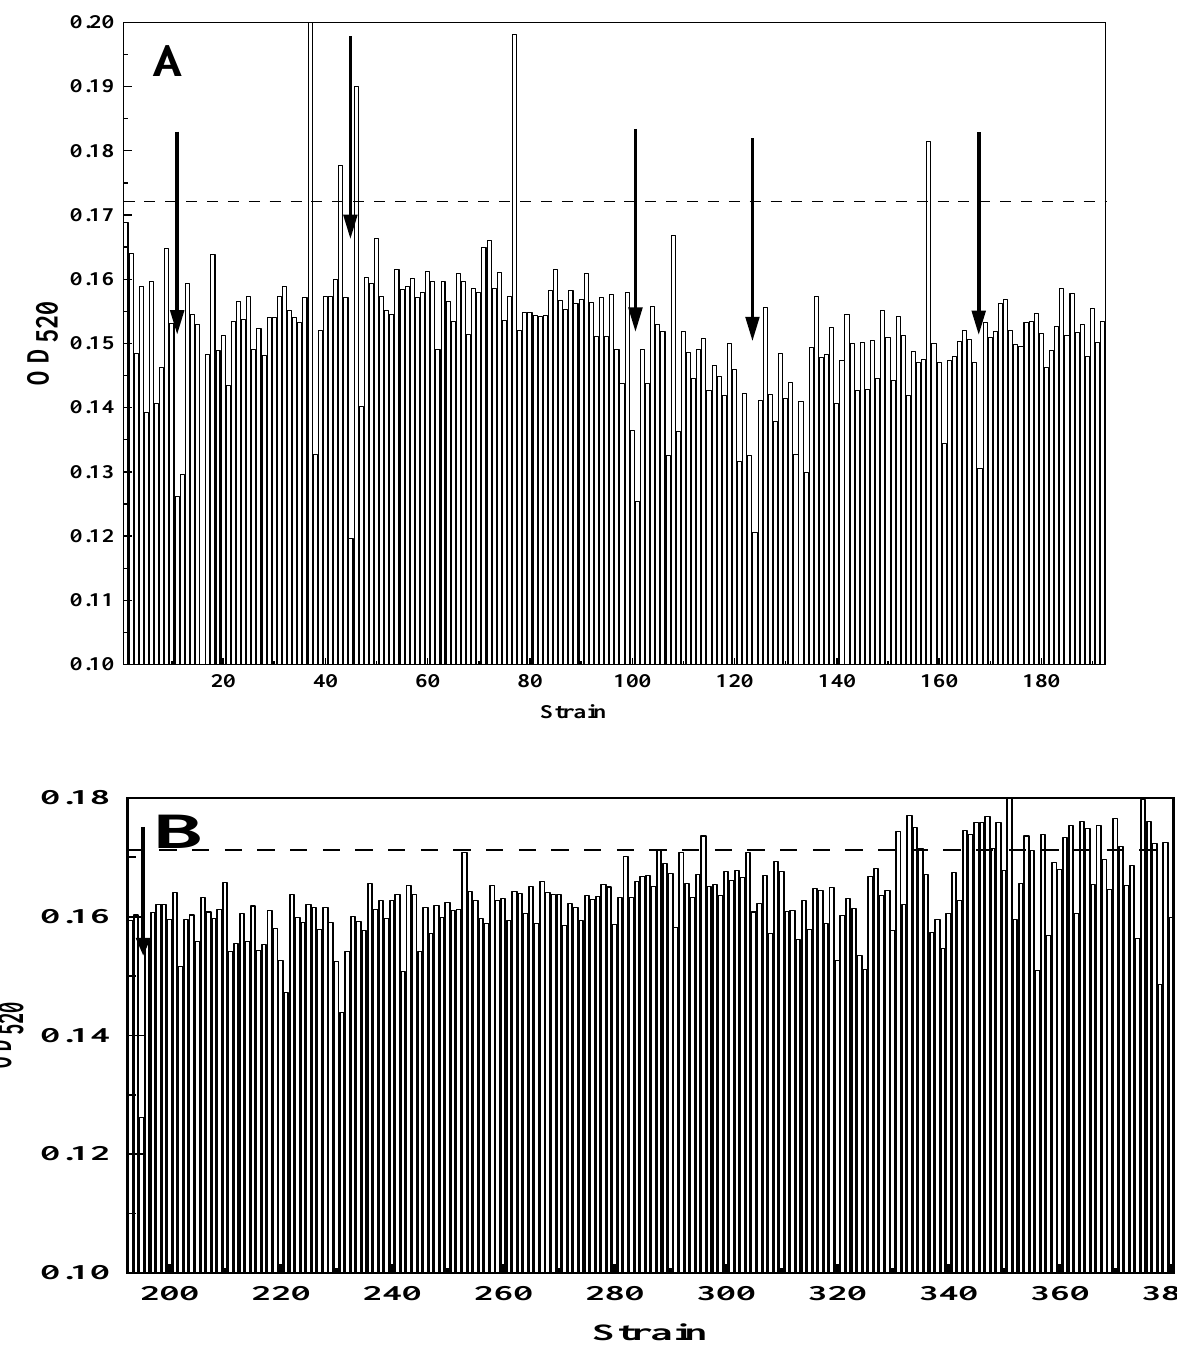
Figure 5. Isolation of mutant strains by Py-Fe3+. ( A , B ) The 380 mutant strains were selected and cultured on 48-well plates. Fermentation broth supernatant (120 µL) and 80 µL ferric nitrate (1 M) were reacted at room temperature for 10 min and OD 520 measurements were performed. (----) The dashed line represents the OD 520 value of S. cerevisiae GJ2008 fermentation under the same conditions(The arrows indicate the selected strains).